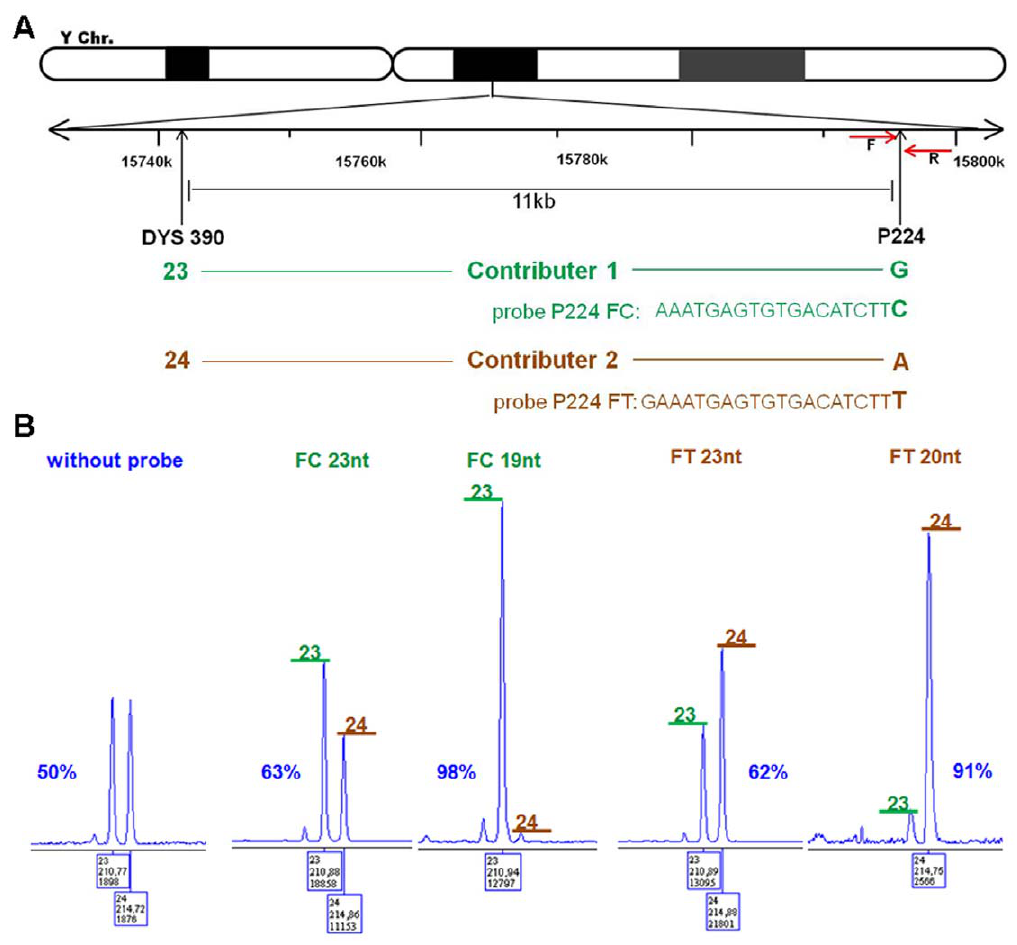
Figure 3. Specific extraction at the P224 locus by HSE and evaluation by AmpF , STR H Yfiler PCR. (A) Map of the 11 kb distant DYS390 and P224 loci on the human Y chromosome, which were selected for HSE analysis. Arrows indicate the positions of the probes used (RG, FC, FT, or RA), which were orientated in either the forward (F) or reverse (R) direction. Given chromosome positions are from a reference sequence (Hg18). (B) Electropherograms of AmpF , STR H Yfiler analysis of haplo-separated samples obtained from a DNA mixture (Contributor 1 and Contributor 2) using the probes P224FC (23 and 19 nucleotides long) and P224FT (23 and 20 nucleotides long), or without probes. Green bars with allele 23 correspond to Contributor 1, and brown bars with allele 24 correspond to Contributor 2. Percentages indicate the enrichment of one